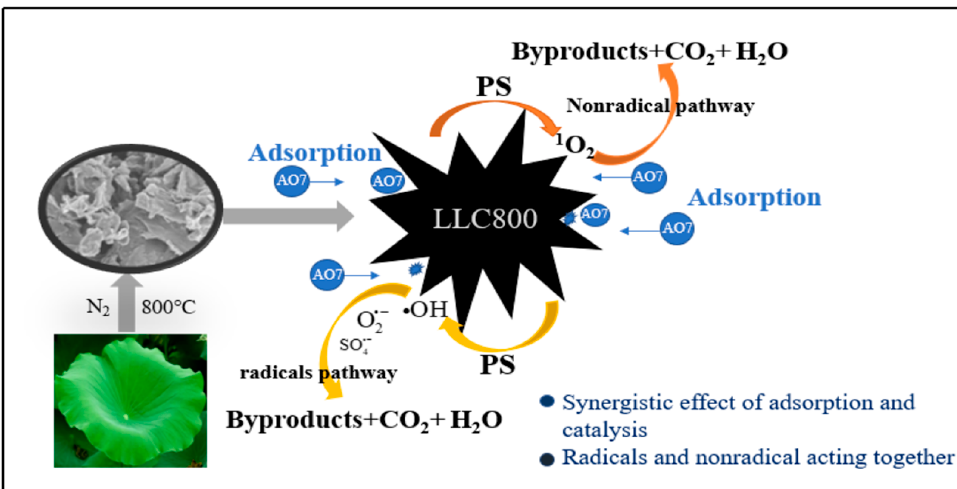
Figure 10. Degradation mechanism of AO7 by LLC800/PS system.